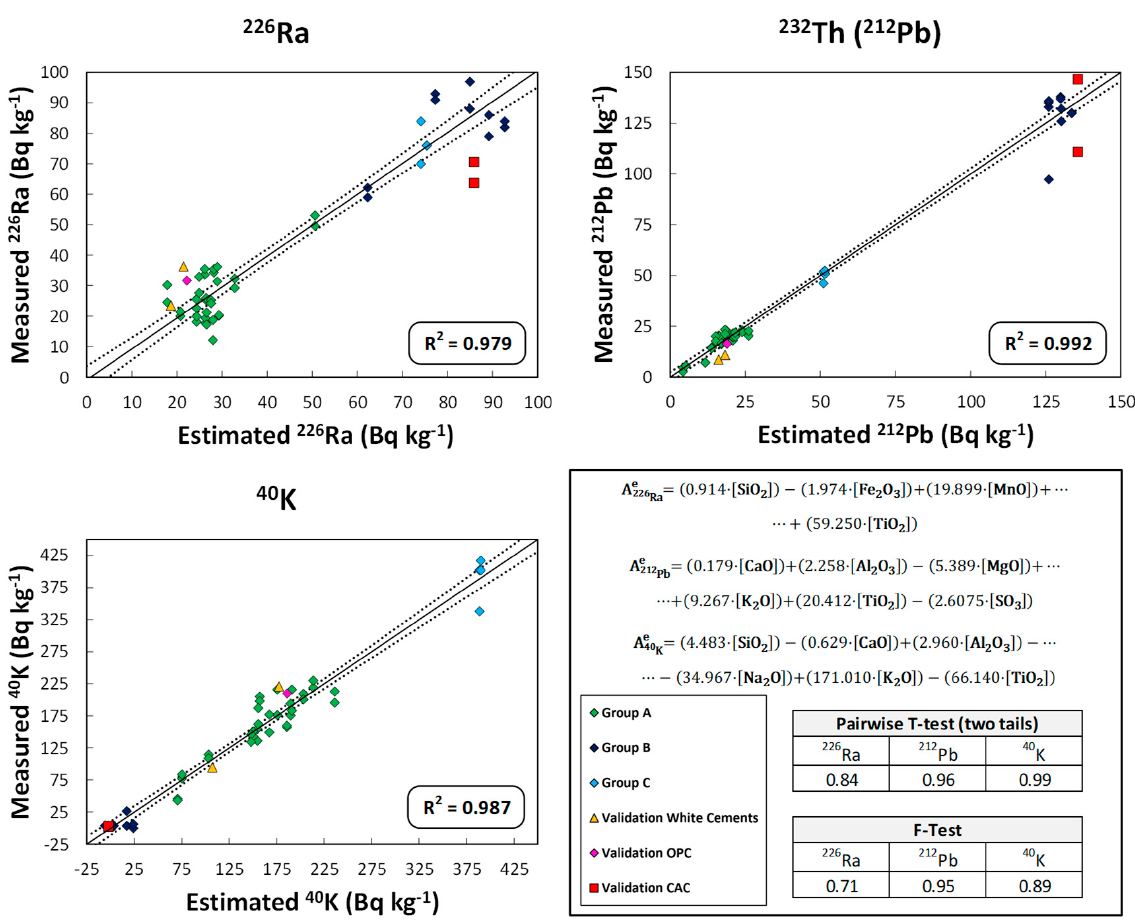
Figure 6. Graphical representation of the activity concentration values of 226 Ra, 232 Th( 212 Pb), and 40 K measured experimentally versus those estimated using the models obtained that relate the chemical composition of the cements to the activity concentration of the different radionuclides. The models explain more than 98% of the dispersion. The clusters depicted by the confidence ellipses in Figure 3 are shown in the same color at the represented points (dark blue for CAC, green for CEM I and white cements, and light blue for CEM I type cements with higher 210 Pb content). The comparison between the experimental and estimated values showed no significant differences, as the p -value for the paired t -test and Fisher’s F-test were higher than the significance value α 0.05. The values obtained in the validation of the method are included to check their agreement with the proposed model. The chemical composition and activity concentrations of the samples analyzed in validation are given in Tables S8 and S9 of the Supplementary